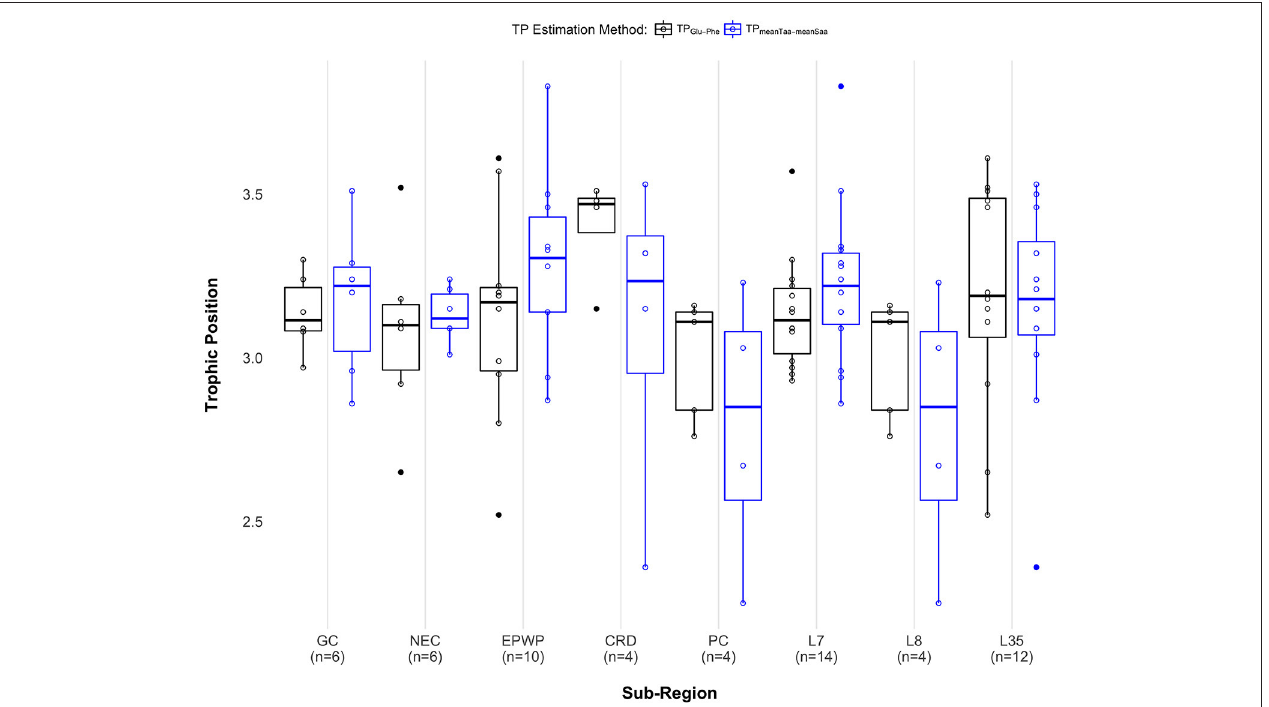
FIGURE 4 | Paired boxplots show individual trophic position estimates as open black circles for the two-amino acid approach (TP Glu − Phe ) and open blue circles for the weighted mean approach (TP meanTaa − meanSaa ). Median trophic position for each method is indicated as a dark black (TP Glu − Phe ) or a blue (TP meanTaa − meanSaa ) band within each box, first and third quartiles as the lower and upper box sections, respectively, and the minimum and maximum estimates as whiskers. Outliers are displayed as solid circles. Sample sizes are labeled along the x-axis as follows: GC, Gulf of California ( n = 6); NEC, North Equatorial Current ( n = 6); EPWP, East Pacific Warm Pool ( n = 10); CRD, Costa Rica Dome ( n = 4); PC, Peru Current ( n = 5 for the two-amino acid method; n = 4 for the weighted mean method); L7, Central American Coastal ( n = 14); L8, Chile-Peru Current ( n = 4); L35, North Pacific Equatorial Countercurrent ( n = 12). Note that only the pair PC and L8 include the exact same data points. See Supplementary Material Data Table 2 for complete AA-CSIA data, including error propagation.